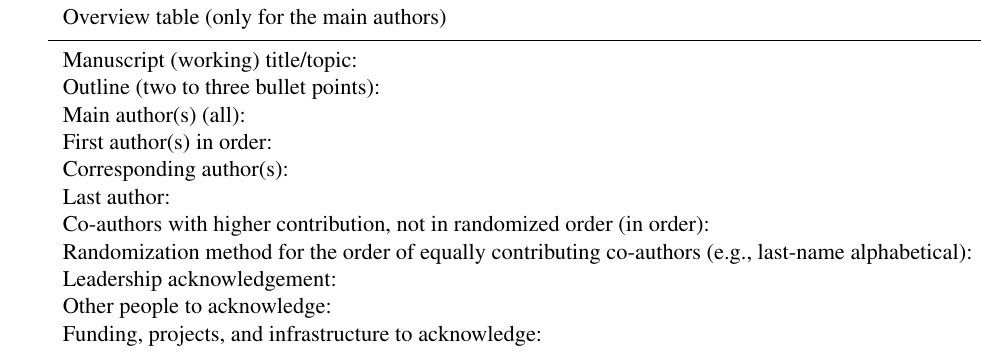
Table 1. The overview section of the authorship form. See Sect. S2.1 in the Supplement for the unabridged authorship form. Overview table (only for the main authors)